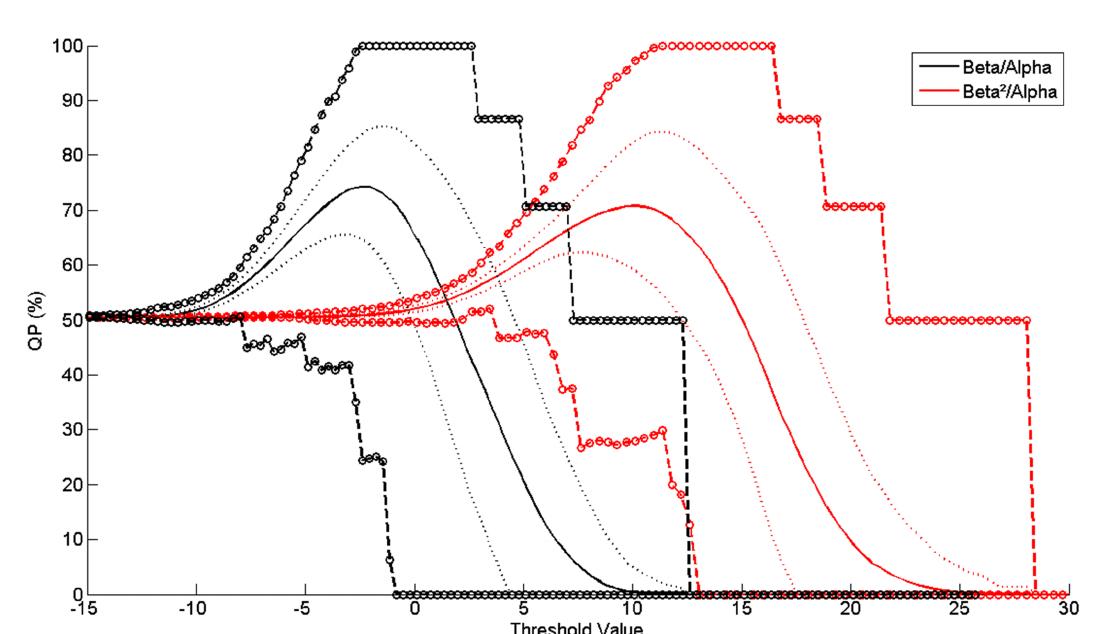
Figure 14. QP obtained as a function of the threshold of ERD/ERS used. Continuous trace: mean values. Dotted lines: mean ± SD. External lines with larger dots: 95% confidence